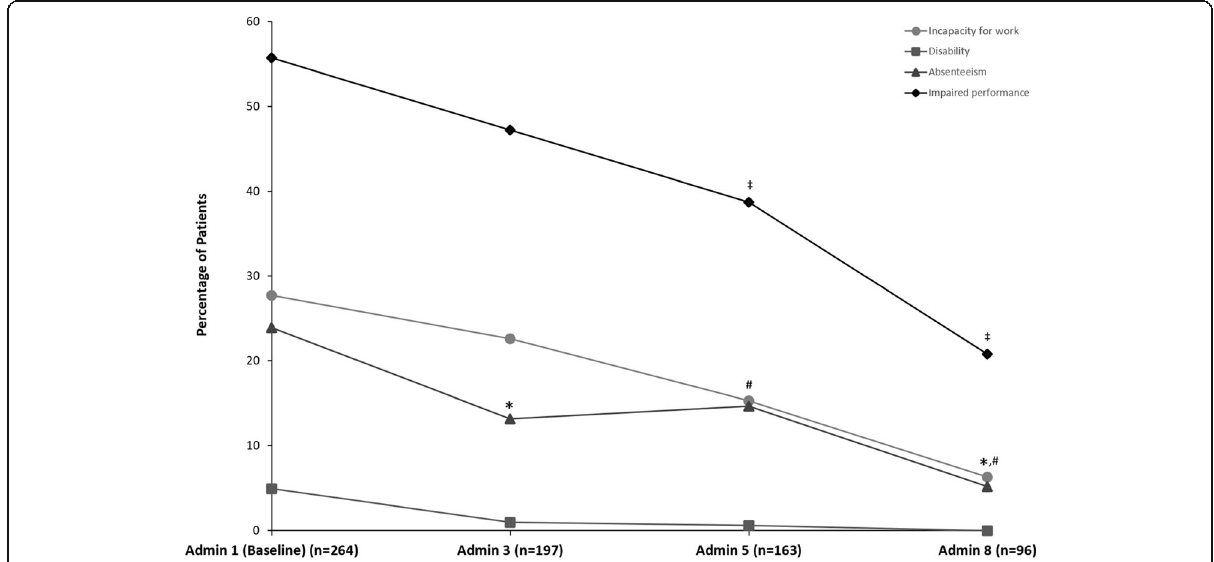
Fig. 4 Health economic questionnaire data from German patients in the SAF enrolled before 08 April 2014. Percentage of patients who had been incapacitated for work ( ● ) or reported a disability ( ■ ) in the last 6 months prior to baseline or since the last visit, and the percentage of patients that had been absent from school or work ( ▲ ) or stated that performance at school or work had been impaired when having a headache at school/work ( ♦ ) in the last 4 weeks prior to baseline or since the last visit. Percentages are related to the number of patients at the respective visit. Non-overlapping 95% confidence intervals at each time point vs. baseline are denoted by * for absenteeism, # for work incapacity, and ‡ for impaired performance; non-overlapping 95% Cis show statistical